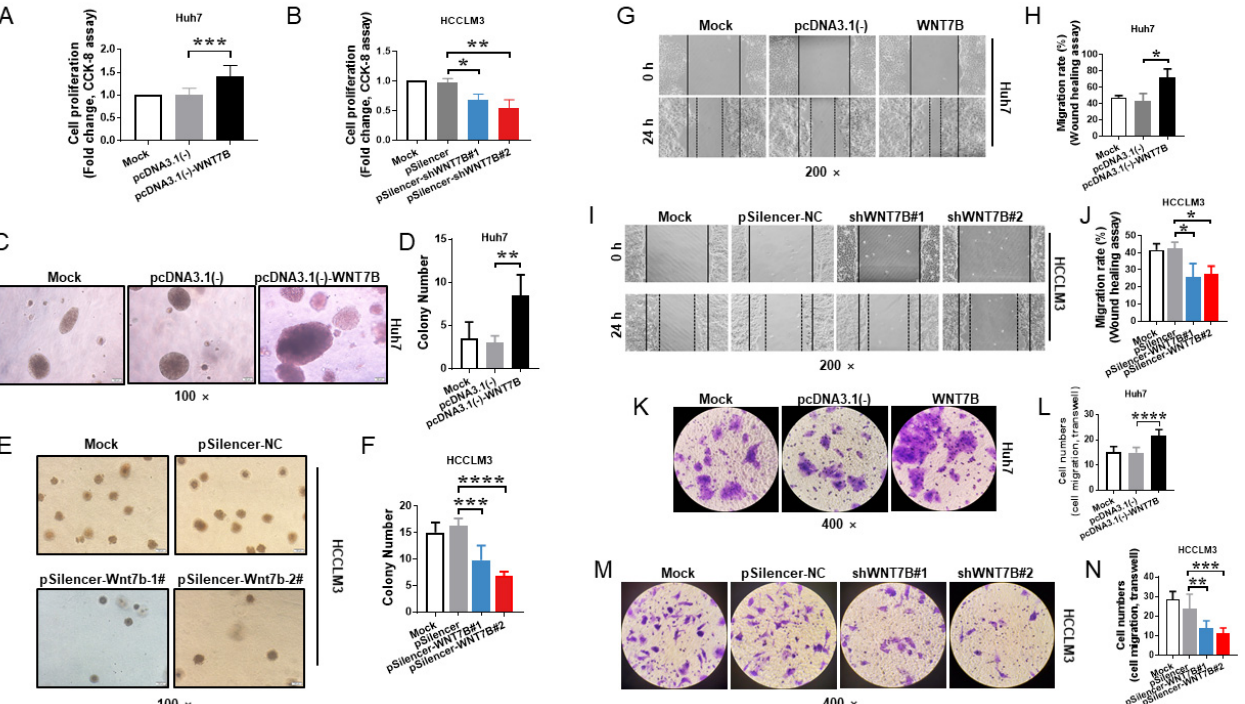
Figure 4. WNT7B causes the malignant properties of HCC. ( A , B ) The CCK-8 assay was used to determine WNT7B’s effect on cell proliferation. ( C – F ) The colony formation assay was utilized to investigate WNT7B’s effect on cell transformation. Representative images are shown (magnification, 100 × ) ( G – J ) The wound healing test was used to study the role of WNT7B in cell migration. Representative images are shown (magnification, 200 × ). ( K – N ) The role of WNT7B on cell invasion was studied using the Transwell assay. Representative images are shown (magnification, 400 × ). All graphs reflect the mean ± SD of at least three independent experiments. * p < 0.05, ** p < 0.005, *** p < 0.001, **** p < 0.0001.